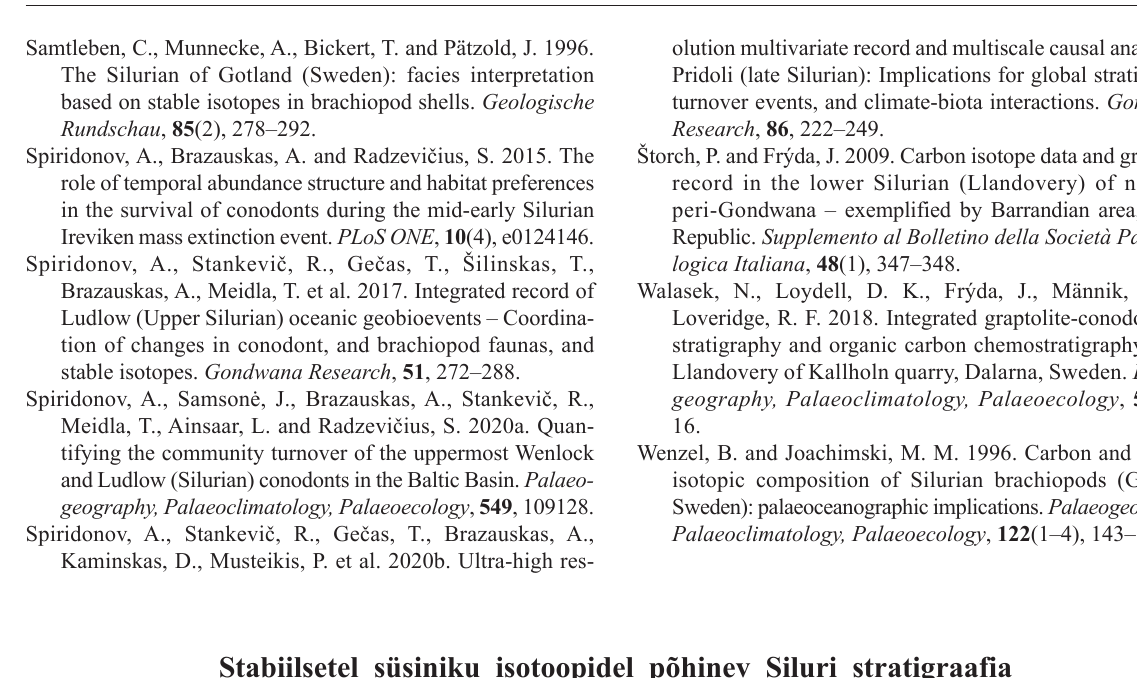
ajastu stratigraafias. Stratigraafilisi skeeme on täiendatud kemostratigraafiliste ühikutega – isotooptsoonidega. δ 13 Ccarb andmestiku kasutamine koos teiste stratigraafiliste meetoditega võimaldab läbilõigete detailsemat liigestamist ja usal- dusväärsemat